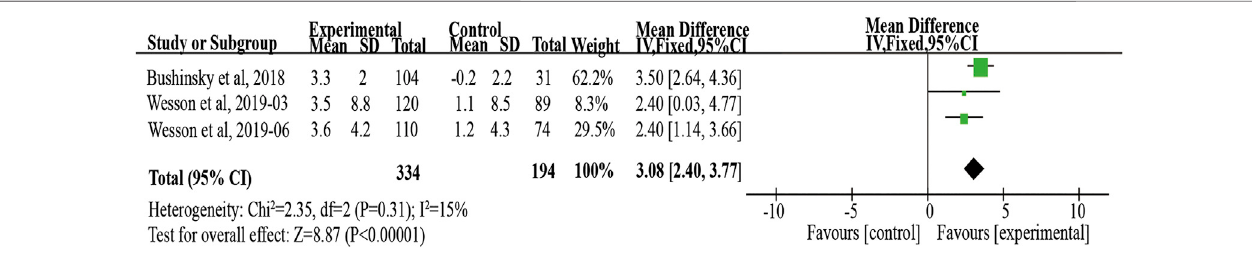
Frontiers in Pharmacology |